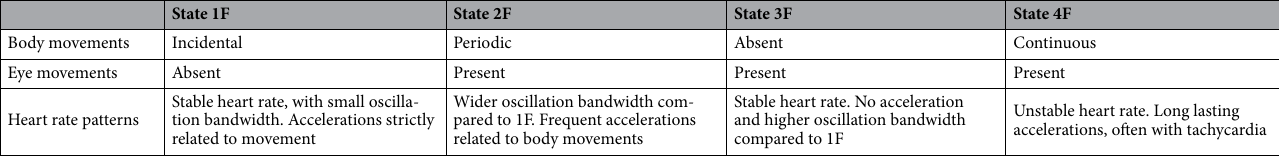
Table 1. Fetal behavioural states original criteria defined by Nijhuis et al. in 1982 2 .